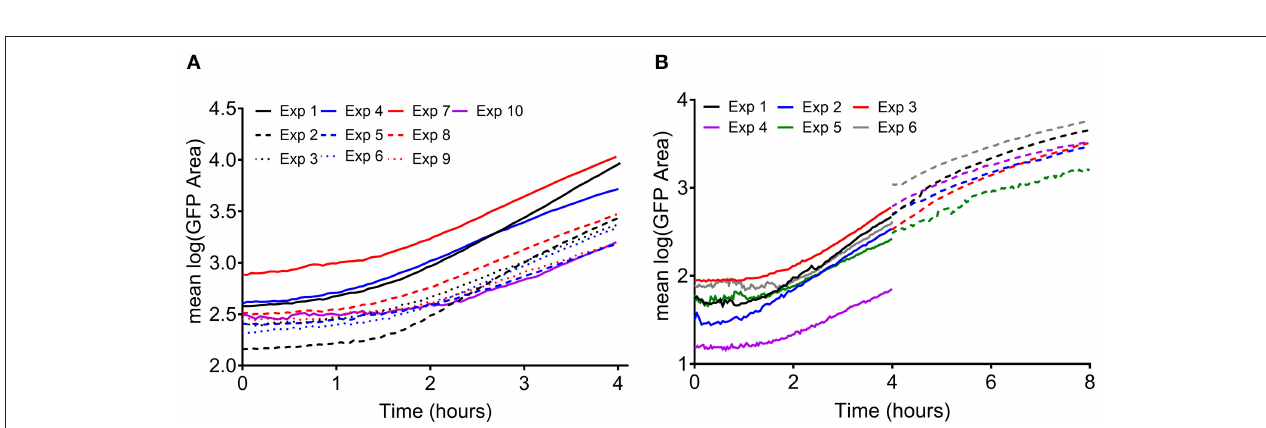
FIGURE 2 | Measured growth of surface adherent S. aureus without an antimicrobial treatment. Each line represents the average of two FOVs from a given experiment. (A) Bacterial growth measured in density experiments (as in Figure 1A , well I). The initial inoculum was measured to be 1.83 ± 1.59 × 10 3 CFUs/cm 2 . (B) Bacterial growth measured in head start experiments (as in Figure 1B ). Solid lines indicate control wells in which single cells were attached and observed for 4h (well IV in Figure 1B ). Dashed lines indicate wells in which bacteria were given 4h to grow prior to the start of imaging, then observed for 4h (hours 4–8, well I in Figure 1B ). The initial inoculum was measured to be 1.93 ± 0.70 × 10 2 CFUs/cm 2